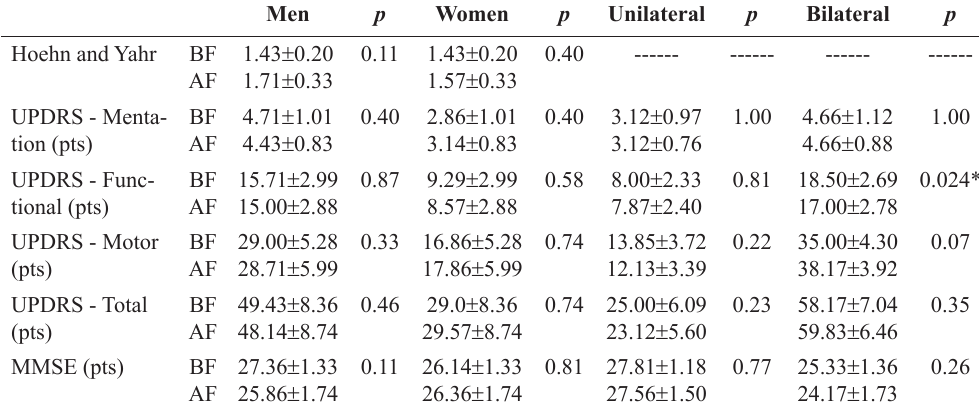
3. Mean, standard deviation, and p-values for the clinical variables according to gender and disease severity, before (BF) and after (AF) exercise